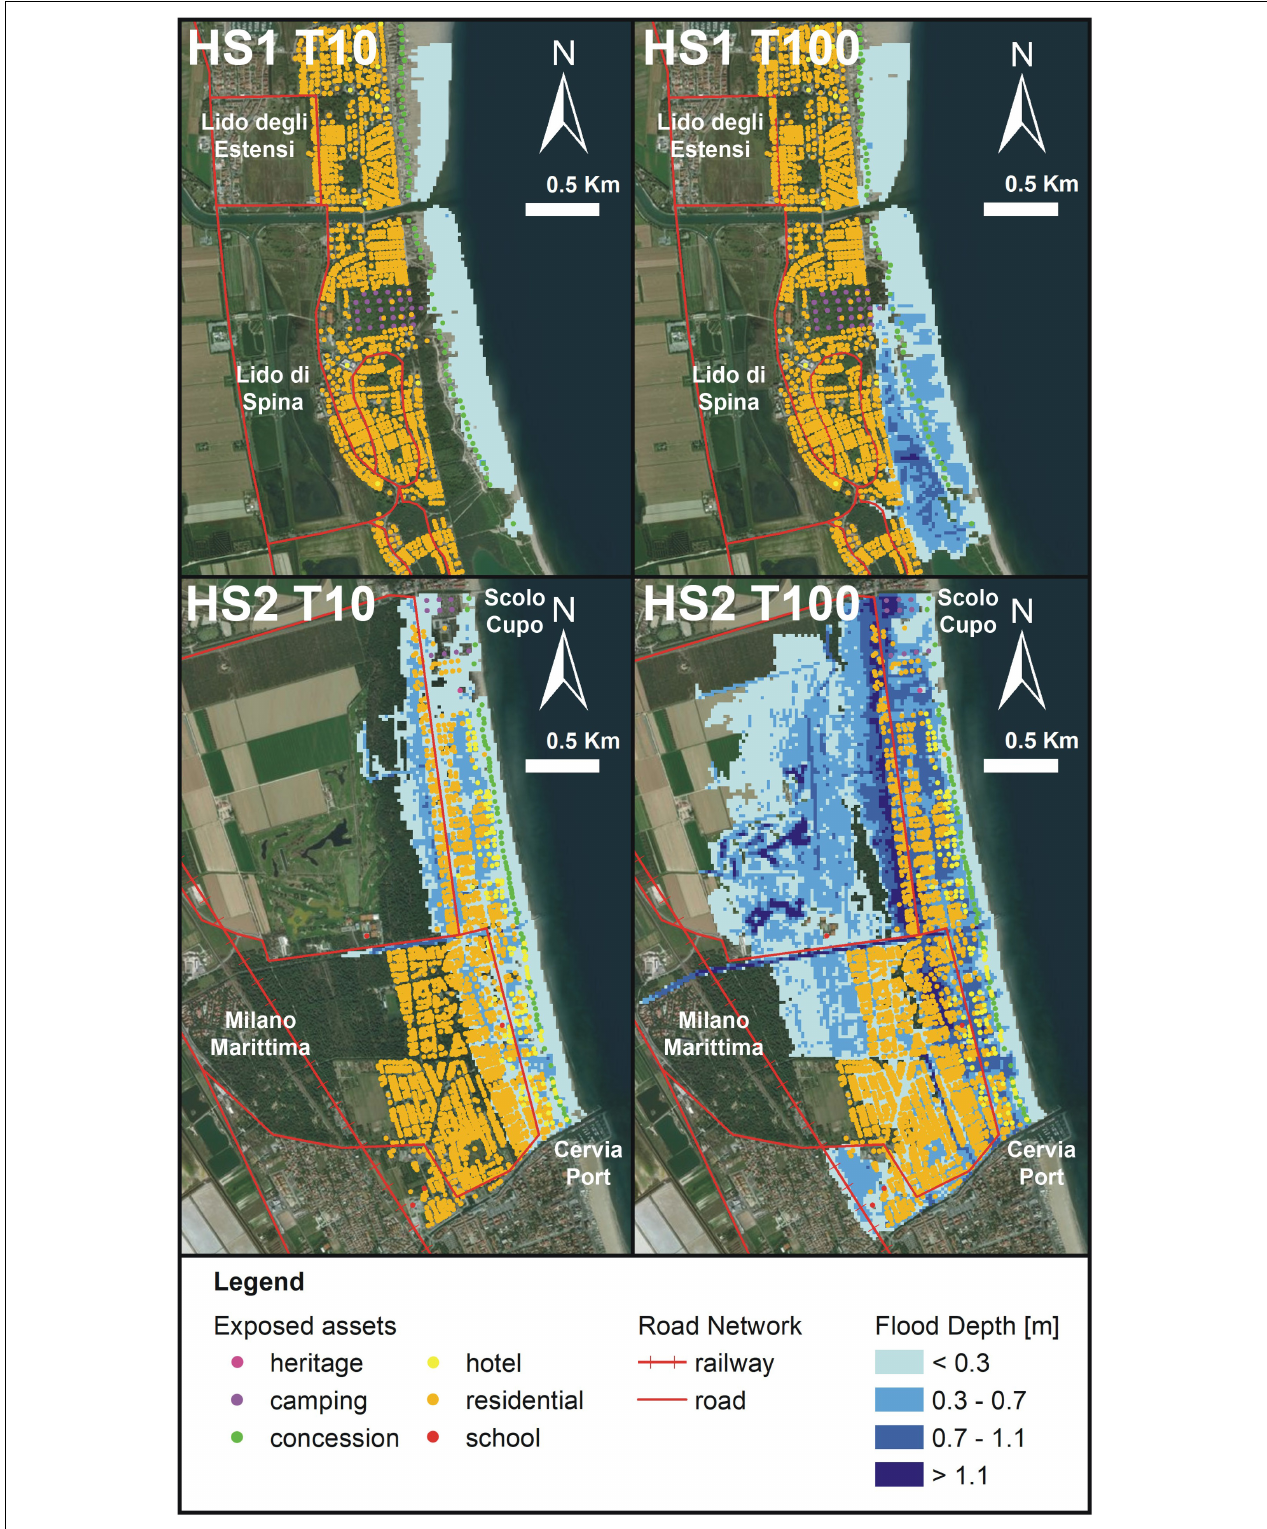
FIGURE 5 | Identified assets and transport network in the two selected hotspots (HS1, Lido degli Estensi-Lido di Spina; HS2, Milano Marittima) and flooding extension. Flood depth calculated through the hazard modeling chain presented in Figure 2 for the two selected storms (T10 and T100) in the two hotspots: HS1, upper figures; HS2, lower figures. The selected classes for the visualization of flood depth values are chosen on the basis of the thresholds presented in Table 4 .